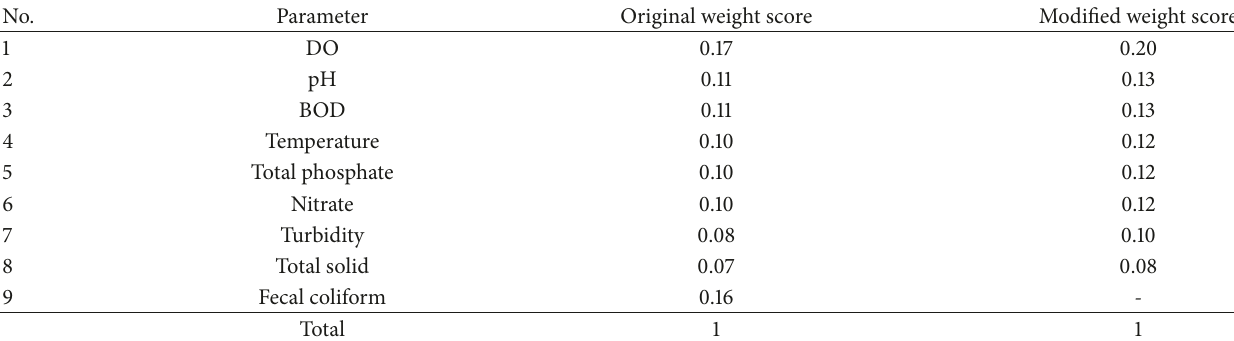
Table 2: New weight score (W i ) for 8 parameters on NSF – WQI